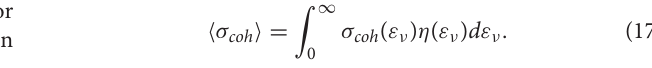
TABLE 2 | Corresponding values of parameters for equivalent Fermi-Dirac (FD) and Power-Law (PL) distributions (SN neutrino energy spectra) of Figure 4 . Parameter Temperature (in MeV) Width ( w ) Pinching ( α ) EQUIVALENT FERMI-DIRAC AND POWER-lAW SUPERNOVA NEUTRINO SPECTRA